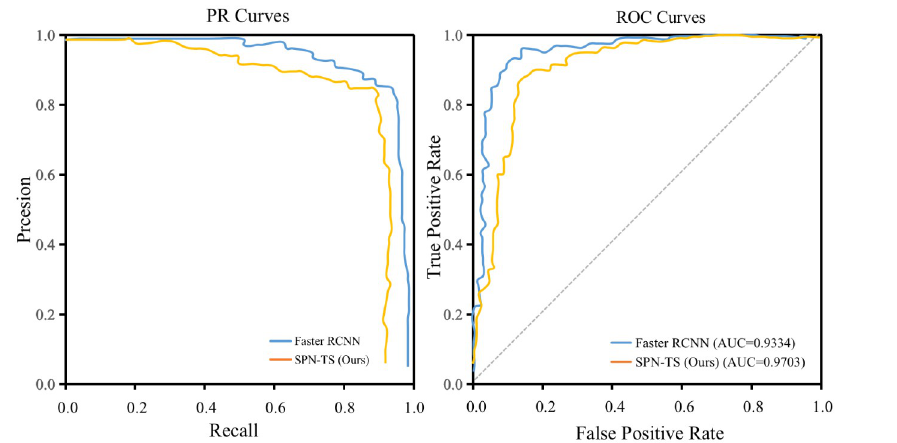
Fig 6. Comparison of PR and ROC curves between Faster RCNN and SPN-TS.